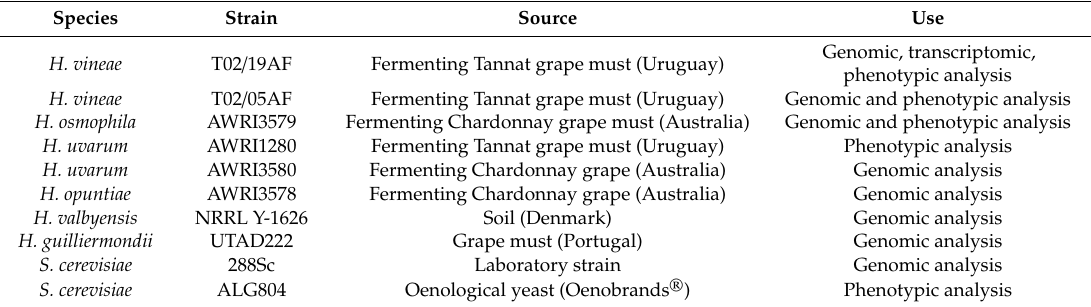
Table 1. Yeast strains used in this